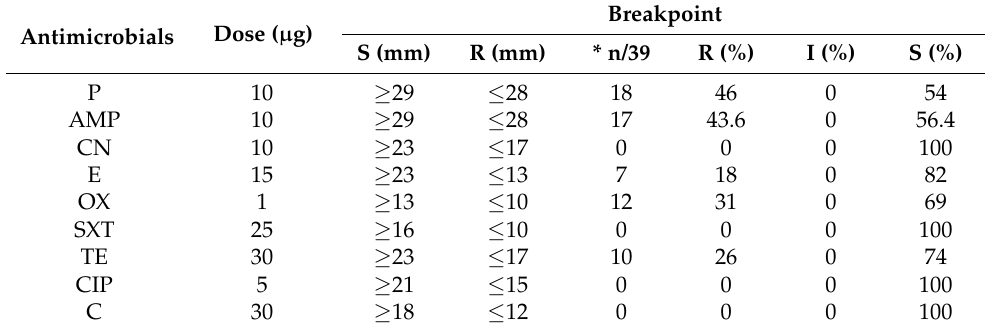
Table 2. Antimicrobial susceptibility of S. aureus isolated from bovine subclinical mastitis. Antimicrobials